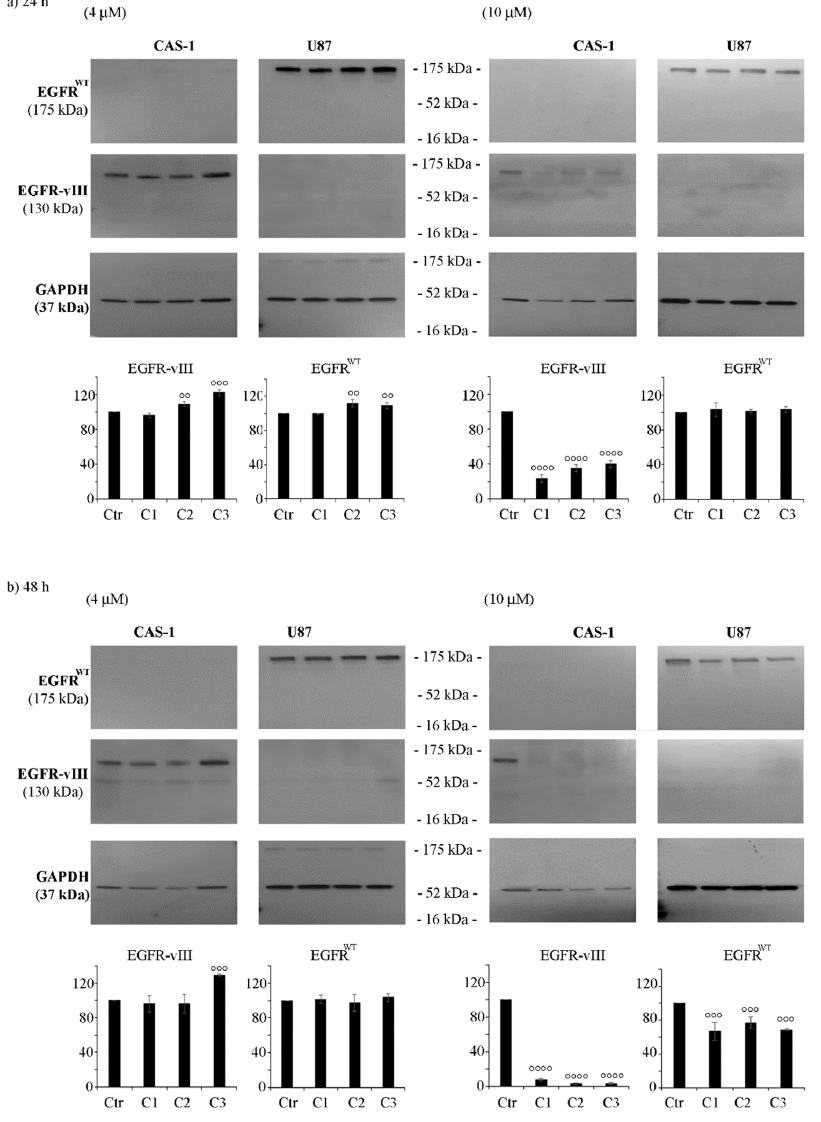
Figure 6. CAS ‐ 1 and U87 cells show a different type of EGFR, and treatment with SI306 or its deriv ‐ Figure 6. CAS-1 and U87 cells show a different type of EGFR, and treatment with SI306 atives differently alters their expression levels. The expression of EGFR WT or EGFR ‐ vIII was evalu ‐ or its derivatives differently alters their expression levels. The expression of EGFR WT ated by immunoblot analyses performed on protein extracts obtained by CAS ‐ 1 (left panels) and